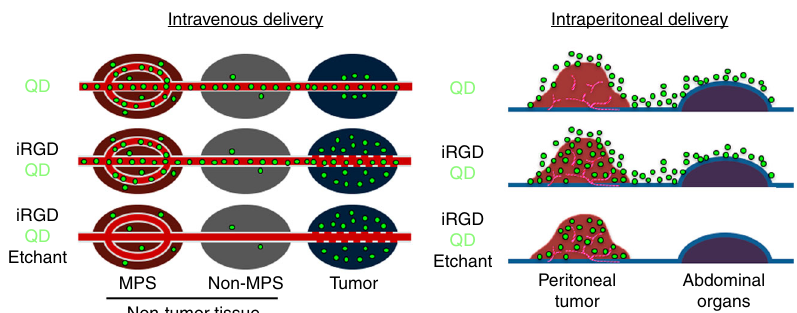
Fig. 8 Tumor-speci fi c imaging with etchable QDs. (Intravenous delivery) Schematic of tumor-speci fi c imaging with tumor-penetrating etchable QDs delivered through the circulation. The schematic depicts an early post-etching time point. Top panel : QDs ( green particles ), when injected alone, eventually accumulate mainly in the MPS by passing through the rich sinusoids. Some QDs may enter the extravascular tumor tissue because of the EPR effect. Middle panel : Pre-injection of iRGD facilitates extravasation and cell internalization of QDs in a tumor-speci fi c manner. The QDs also eventually accumulate in the MPS. Bottom panel : Etching performed soon after the iRGD-mediated QD delivery into extravascular tumor cells causes quenching of intravascular and extracellular QDs leading to highly tumor-speci fi c signals. (Intraperitoneal delivery) Schematic of peritoneal tumor imaging with intraperitoneally delivered etchable QDs. Top panel : intraperitoneal QDs attach to the tumor and peritoneal surfaces. Middle panel : iRGD facilitates local penetration of QDs speci fi cally into peritoneal tumors. Bottom panel : Intraperitoneal etching differentially quenches the QDs that did not enter the tumors without affecting the intratumoral QDs, leading to highly tumor-speci fi c